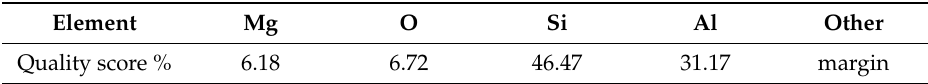
Figure 7. The energy spectrum analysis of the SiCp/Al composites ; ( a ) Energy spectrum analysis block diagram; ( b ) SiCp/Al chemical compositions.